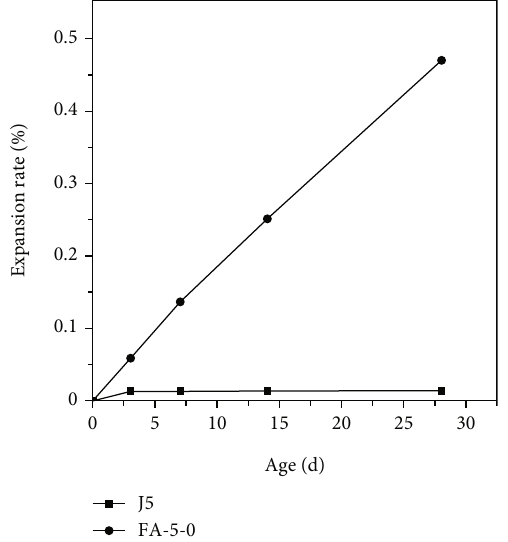
Figure 6: The diagram between FA-3-0 benchmark specimen and age.